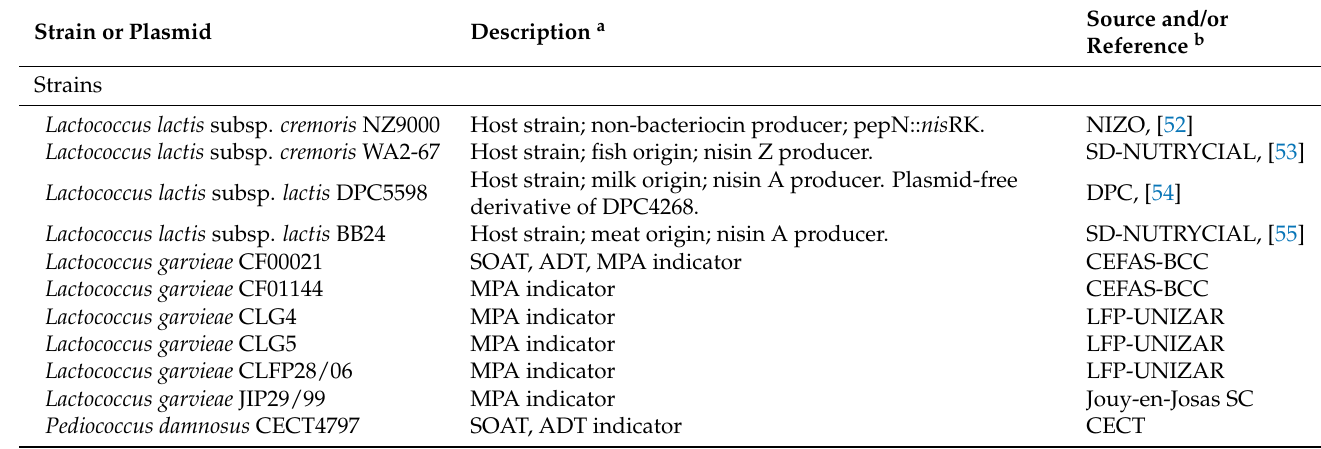
Table 1. Bacterial strains and plasmids used in this